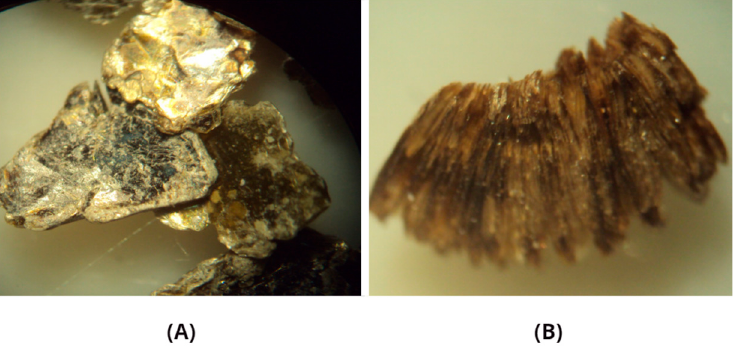
Figure 4. Fragments of crude vermiculite ( A ) and expanded vermiculite ( B ) under a microscope [26].